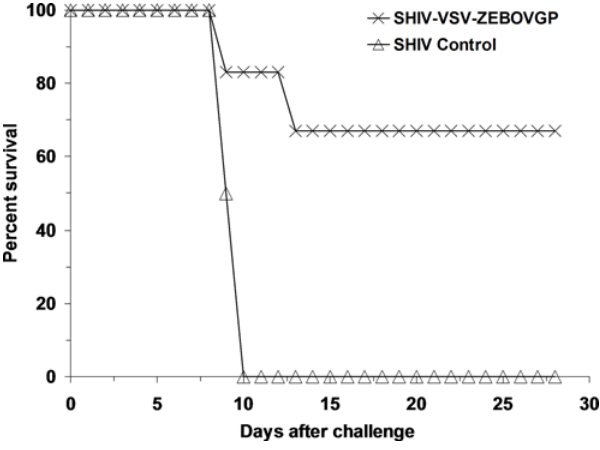
Figure 2. Kaplan-Meier survival curves for SHIV-infected rhesus macaques vaccinated with VSV D G/ZEBOVGP and challenged 31 days later with ZEBOV.